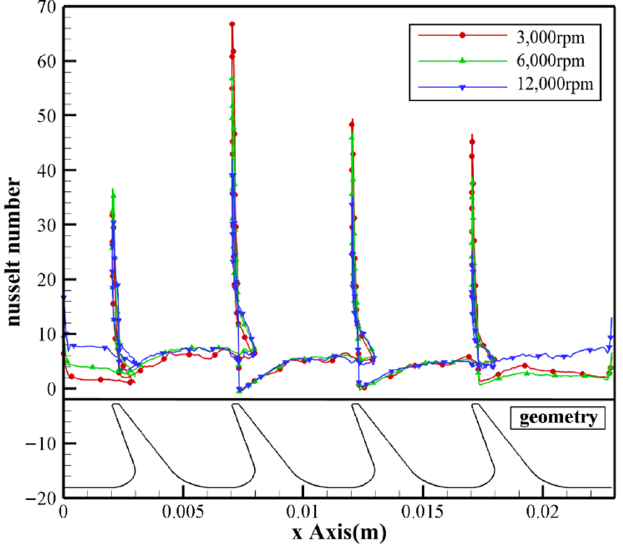
Figure 17. Nusselt number distribution along the tooth surface.